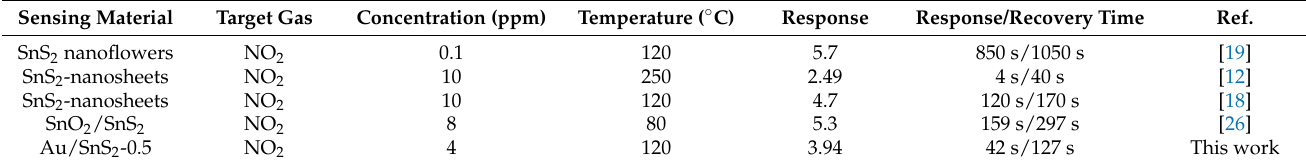
Figure 12. ( a ) The repeatability of the Au/SnS 2 -0.5-based sensor to 4 ppm NO 2 at 120 °C. ( b ) The long-term stability of the sensor. Table 1. A comparison of the NO 2 sensing performance of SnS 2 -based sensors.